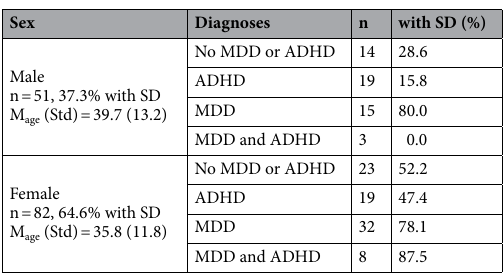
Table 1. SD prevalence for MDD and ADHD. Prevalence of SD by Sex, the diagnosis of MDD, ADHD. M denotes mean, SD denotes standard deviation.